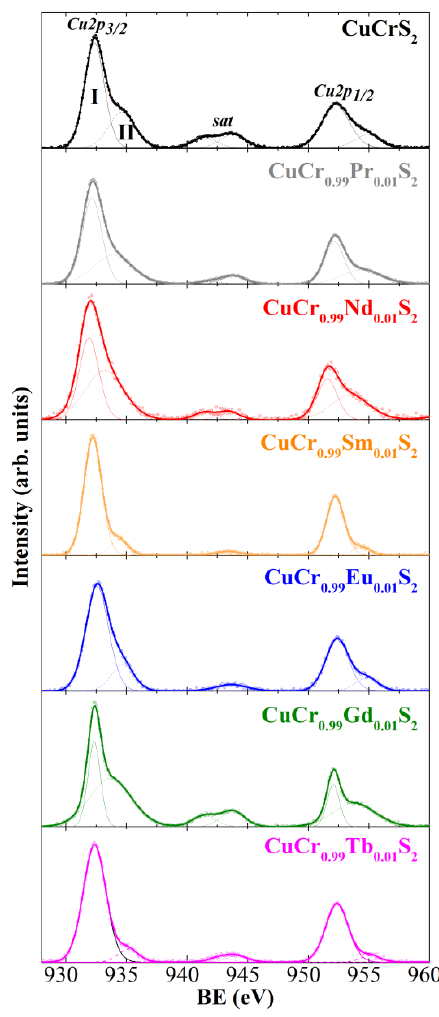
Figure 2. X-ray photoelectron Cu2p region for CuCrS 2 and CuCr 0.99 Ln 0.01 S 2 (Ln = Pr – Tb). Figure 3 plots the Cr2p lines of the samples studied. The Cr2p region exhibits two intense peaks (BE of ~575 and ~584 eV) arising due to the spin-orbit coupling of Cr2p 1/2 and Cr2p 3/2 levels. The Cr2p 1/2 and Cr2p 3/2 lines could be represented as a superposition of two components (denoted as I and II in Figure 3). The low-energy peaks I with a